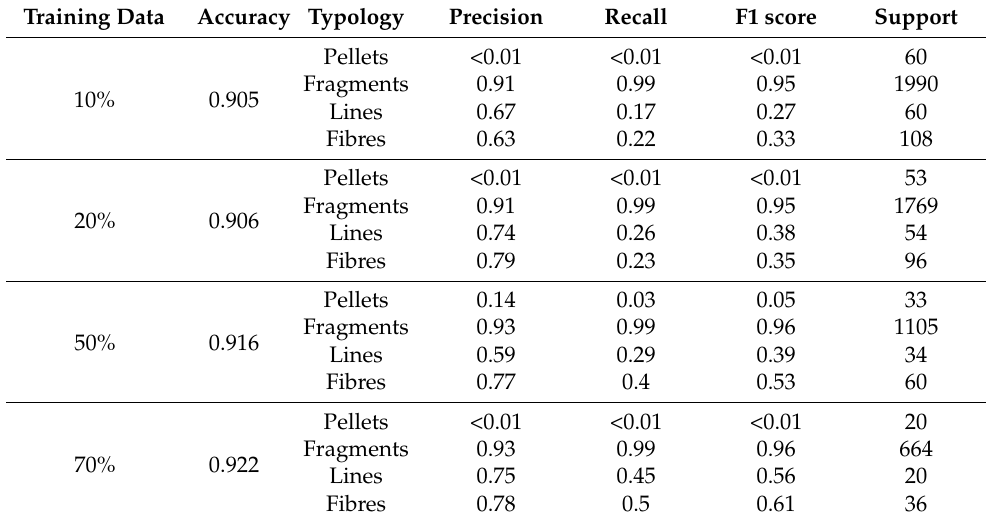
Table 4. Performance of K-NN algorithm using different percentages of training data.